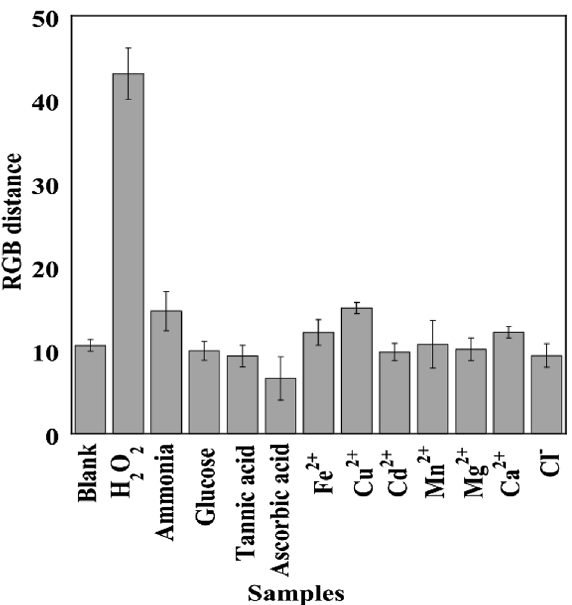
Figure 8. Signal intensity of the color detected by P-AgNPs-100 with different metal ions and